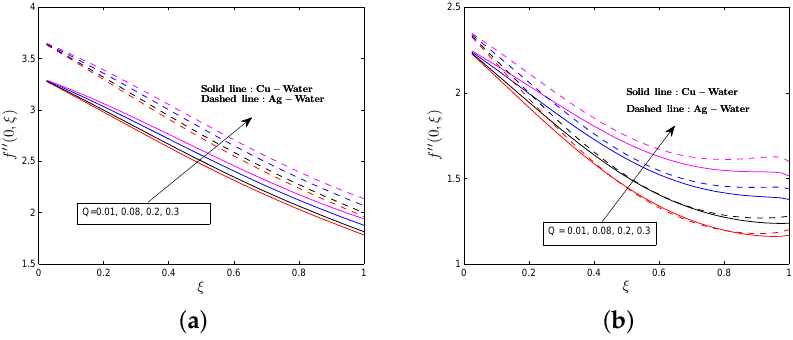
Figure 14. Skin friction for various values of Q . ( a ) vertical plate; ( b ) horizontal plate.